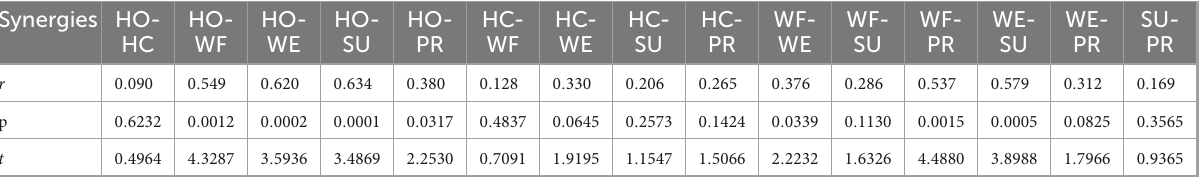
TABLE 3 Spearman’s correlation of representative muscle synergies matrixes during different movements. Synergies HO- HC